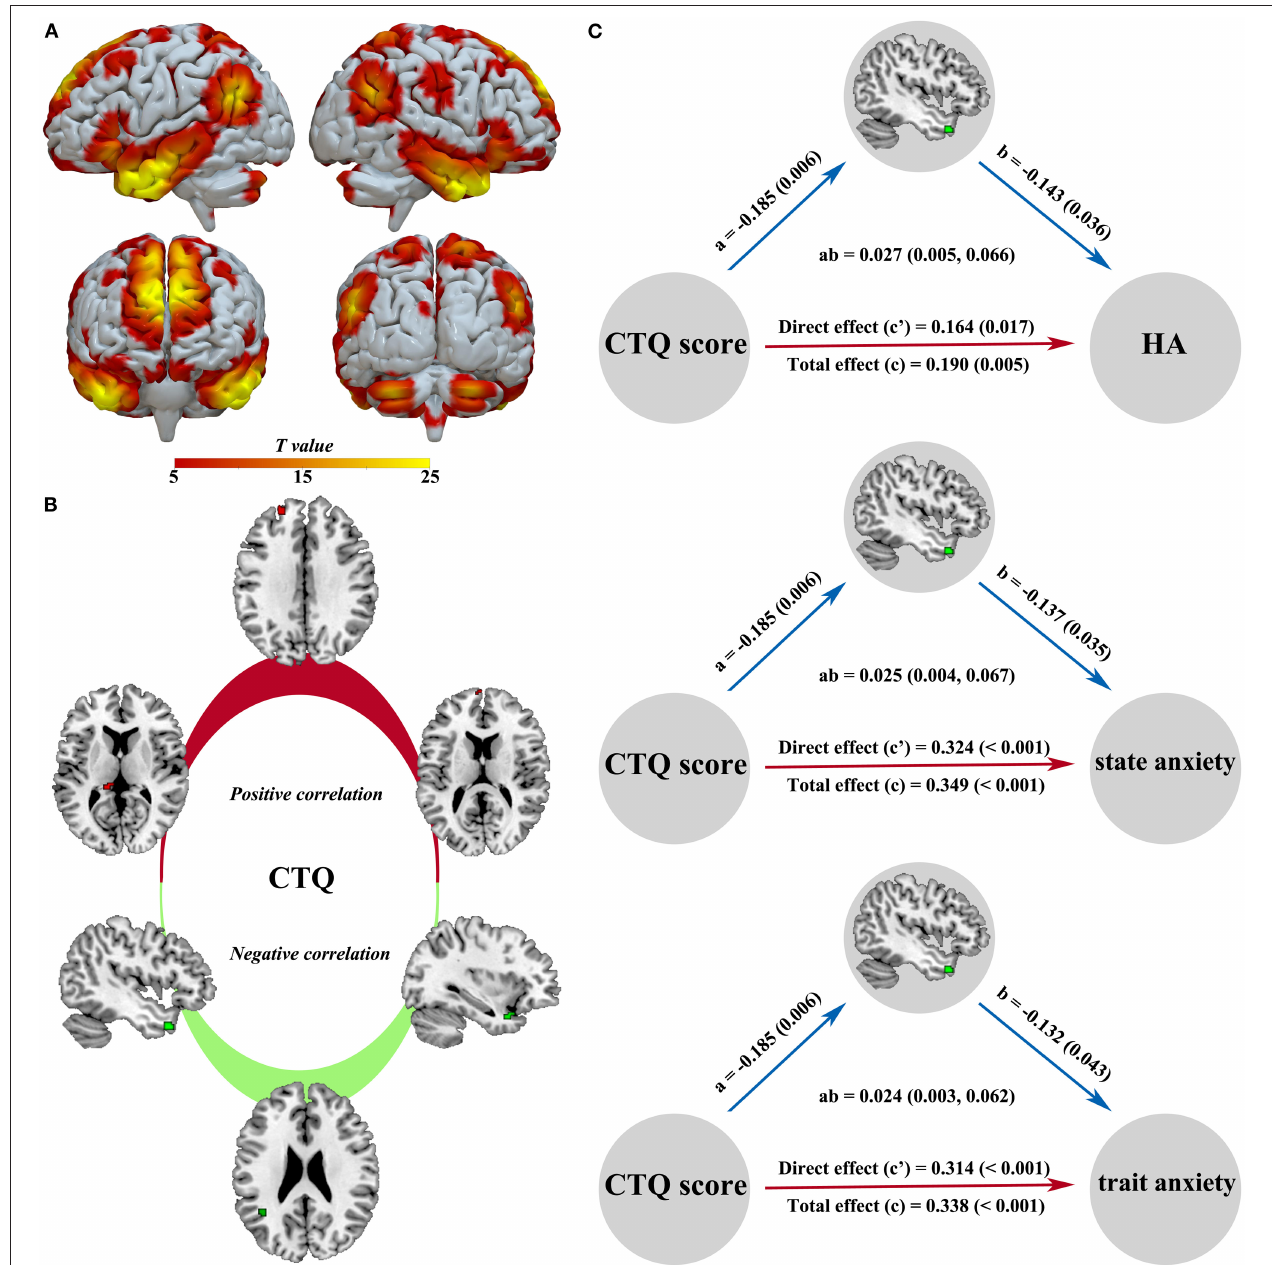
FIGURE 4 | Intra-DMN functional alterations related to the CTQ score and significant mediation effects in the environment-brain-behavior pathway. A sample-specific spatial map of the DMN component is present in (A) . The CTQ score was positively related to the left hippocampus-thalamus region, left superior frontal gyrus, and left medial frontal gyrus, while the CTQ score was negatively correlated with the left temporal pole and left angular gyrus (B) . The connectivity strength of left temporal pole was found as a significant mediator between the CTQ score and emotional behavior (C) . There were significant positive effects from the CTQ score to HA, state anxiety, and trait anxiety, a negative effect from the CTQ score to temporal pole connectivity, and negative effects from the temporal pole connectivity to HA, state anxiety, and trait anxiety. CTQ, Childhood Trauma Questionnaire; DMN, default mode network; HA, harm